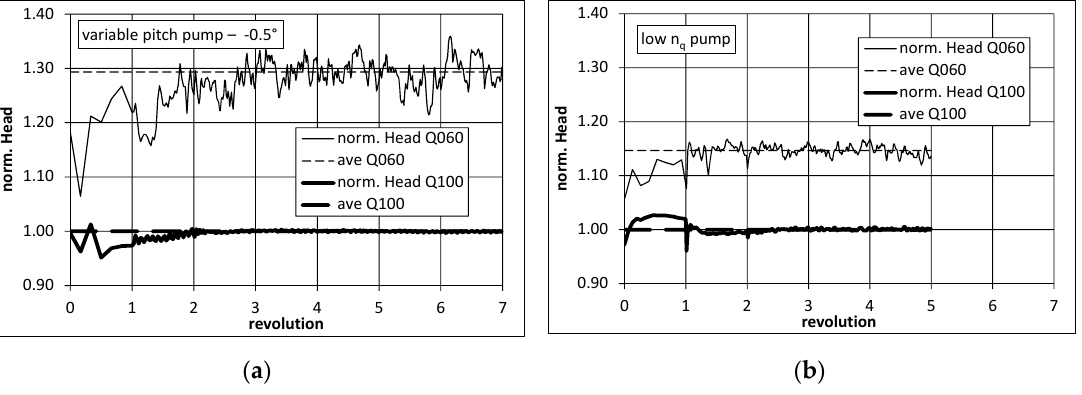
Figure 6. Head history of unsteady simulations: variable pitch at pump -0.5° ( a ) low n q pump ( b ).